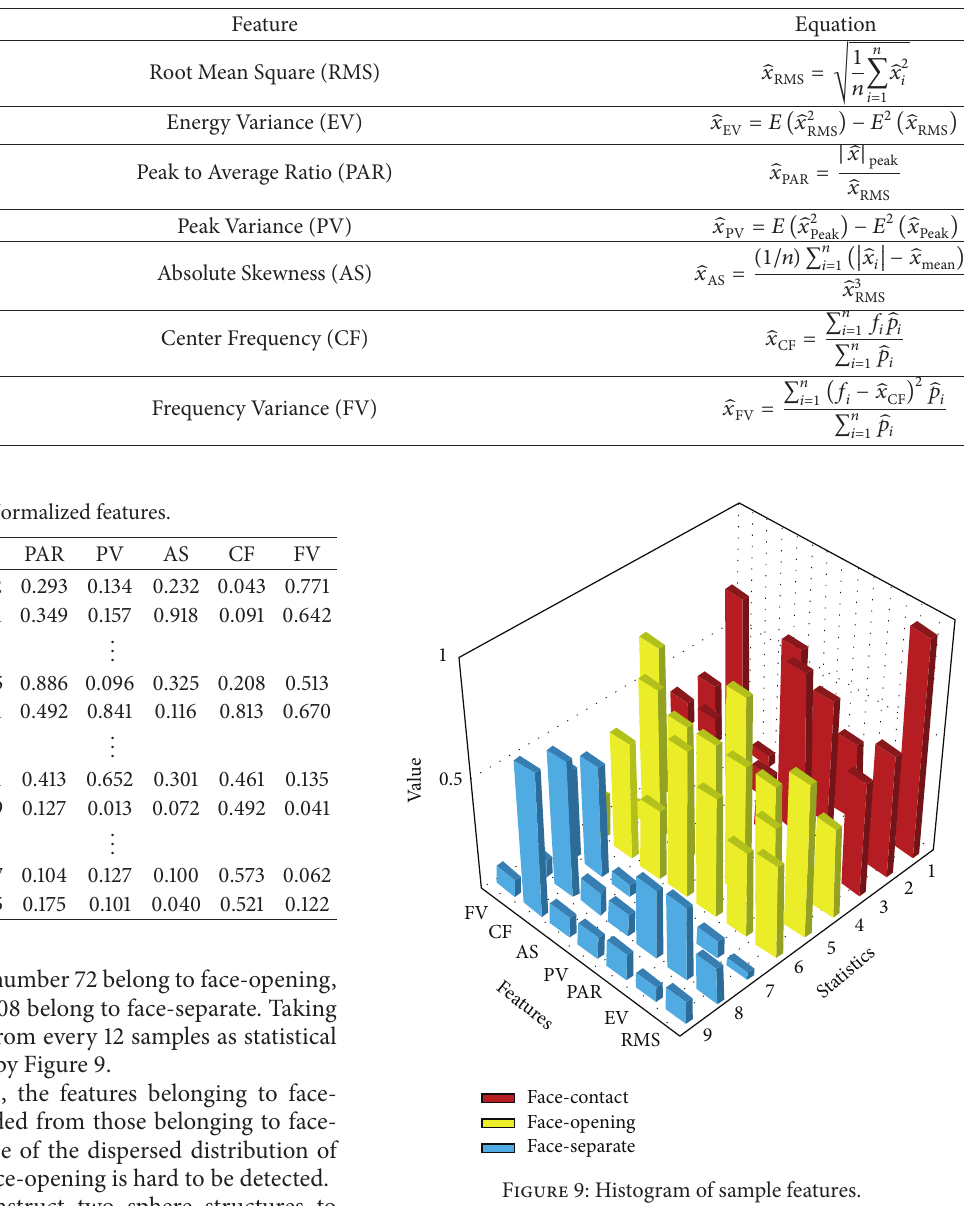
Table 2: Features extraction.